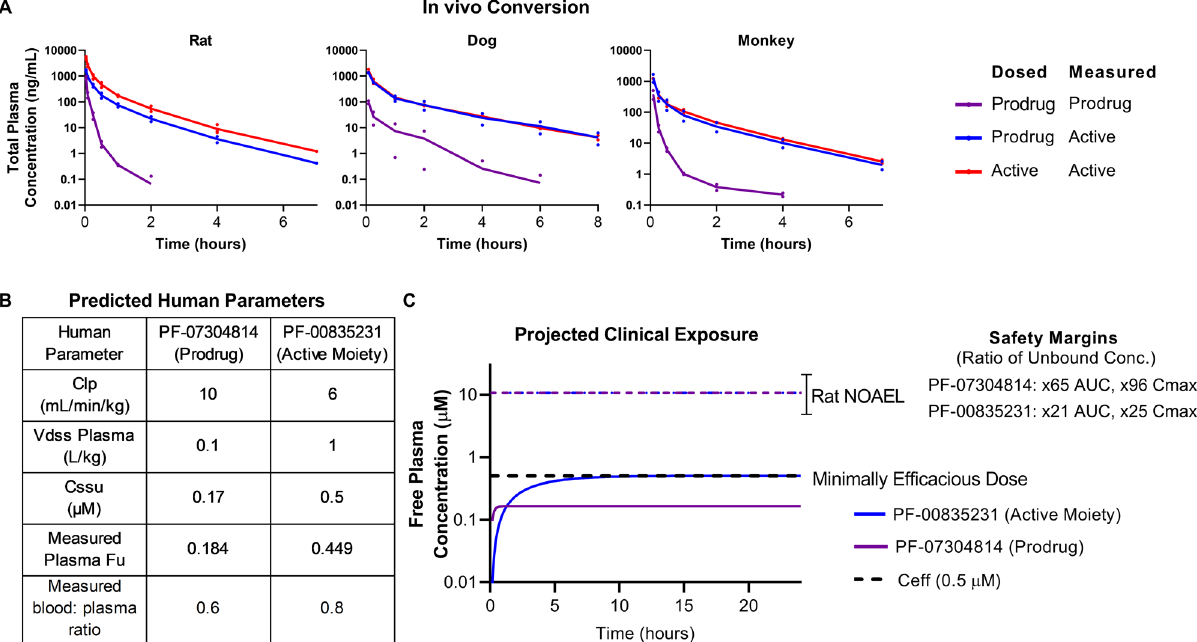
Fig. 6 PF-07304814 (prodrug) and PF-00835231 in vivo exposure summary. A Rat, dog and monkey PK following IV administration of PF-07304814 (1.17 mg/kg) or PF-00835231 (2 mg/kg rat, 1 mg/kg dog and monkey) demonstrating high levels of PF-00835231 formed in vivo. ( n = 2 or 3; individual data points plotted). B Predicted human PK parameters and measured protein binding for PF-07304814 and PF-00835231 used for human dose prediction. C Projected human systemic exposure pro fi les at the minimally ef fi cacious dose of 500 mg/day of PF-07304814 delivered as a continuous IV infusion. The predicted unbound steady-state concentrations for the prodrug PF-07304814 (purple) and the active moiety PF-00835231 (blue) are 0.17 µ M and 0.5 µ M respectively. (NOAEL = No Observed Adverse Effect Level; C eff = projected minimally ef fi cacious concentration, Fu = unbound fraction; Clp = Plasma Clearance; Vdss = Volume of distribution steady state, Cssu = unbound steady-state